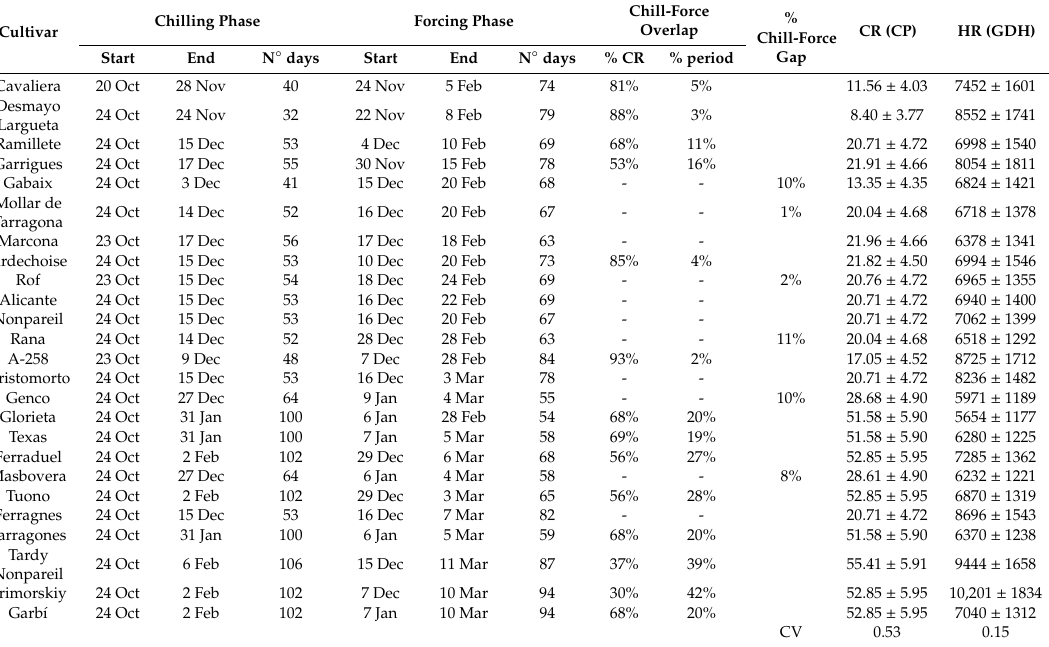
Table 1. ( a ) Almond chill and heat requirements (CR, HR). Chill–Force overlap: % CR, percentage of chill accumulated when overlap with forcing phase started; % period, percentage of total chilling + forcing period in which chilling and forcing phase overlap; and % Chill–Force gap, percentage of total chilling + forcing period in which no chill nor heat is accumulated (gap). Chill and heat requirements (mean ± standard deviation). Chill requirements are expressed in chill portions (CP) and heat requirements in growing degree hours (GDH). CV: coe ffi cient of variation associated to CR and HR. Cultivars are organized according to their average flowering date (from earliest to latest). (-) in column % Chill–Force overlap means that 100% of the chill was accumulated before the start of the forcing phase. ( b ) Apple start and end day of the chilling and forcing phases, % of accumulated chill when forcing phase started, % of the period with overlap (Chill–Force overlap) and % of the period were gap between phases occurs (% Chill–Force gap). Chill and heat requirements (mean ± standard deviation). Chill requirements are expressed in chill portions (CP) and heat requirements in growing degree hours (GDH). CV: coe ffi cient of variation associated to CR and HR. Cultivars are organized according to their average flowering date (from earliest to latest). (-) mean that 100% of the chill was accumulated when the forcing phase